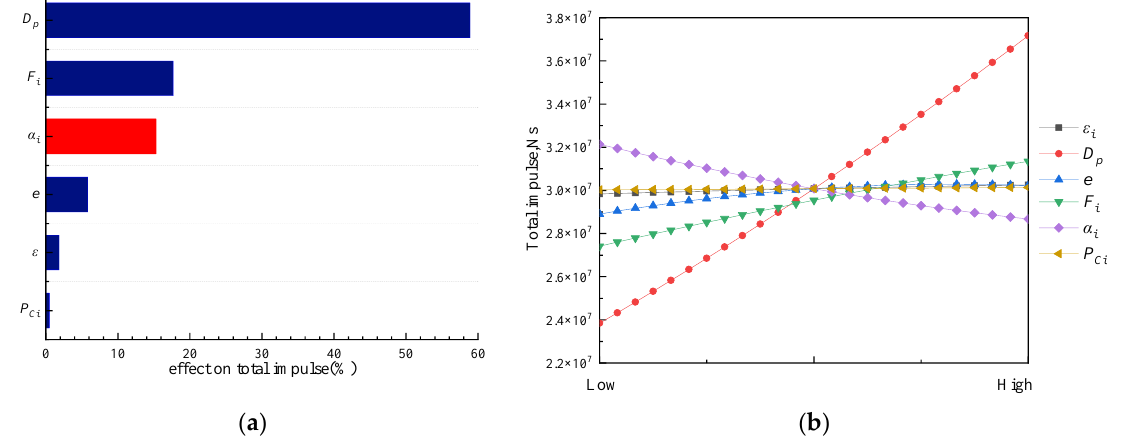
Figure 19. Parametric analysis of design variables to total impulse. ( a ) Pareto diagram; ( b ) main effect plot.